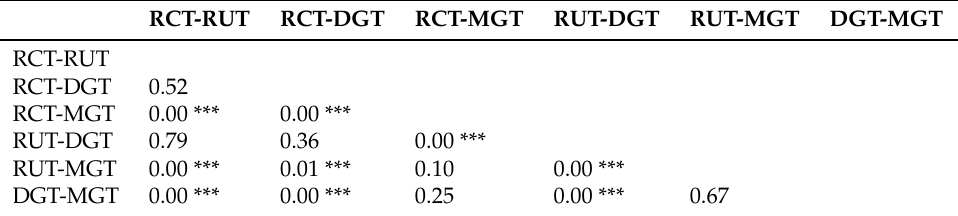
Table 4. Significance levels for pairwise comparisons of absolute differences. Values are p -values from two-sided t -tests, testing whether two values from Table 3 are significantly different from each other. *** if p ≤ 0.01. RCT-RUT RCT-DGT RCT-MGT RUT-DGT